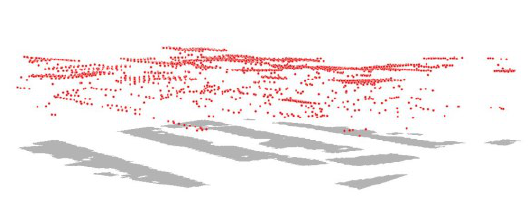
Figure 4. Input LiDAR data in red masked by the corresponding semantic segmentation network prediction in grey.